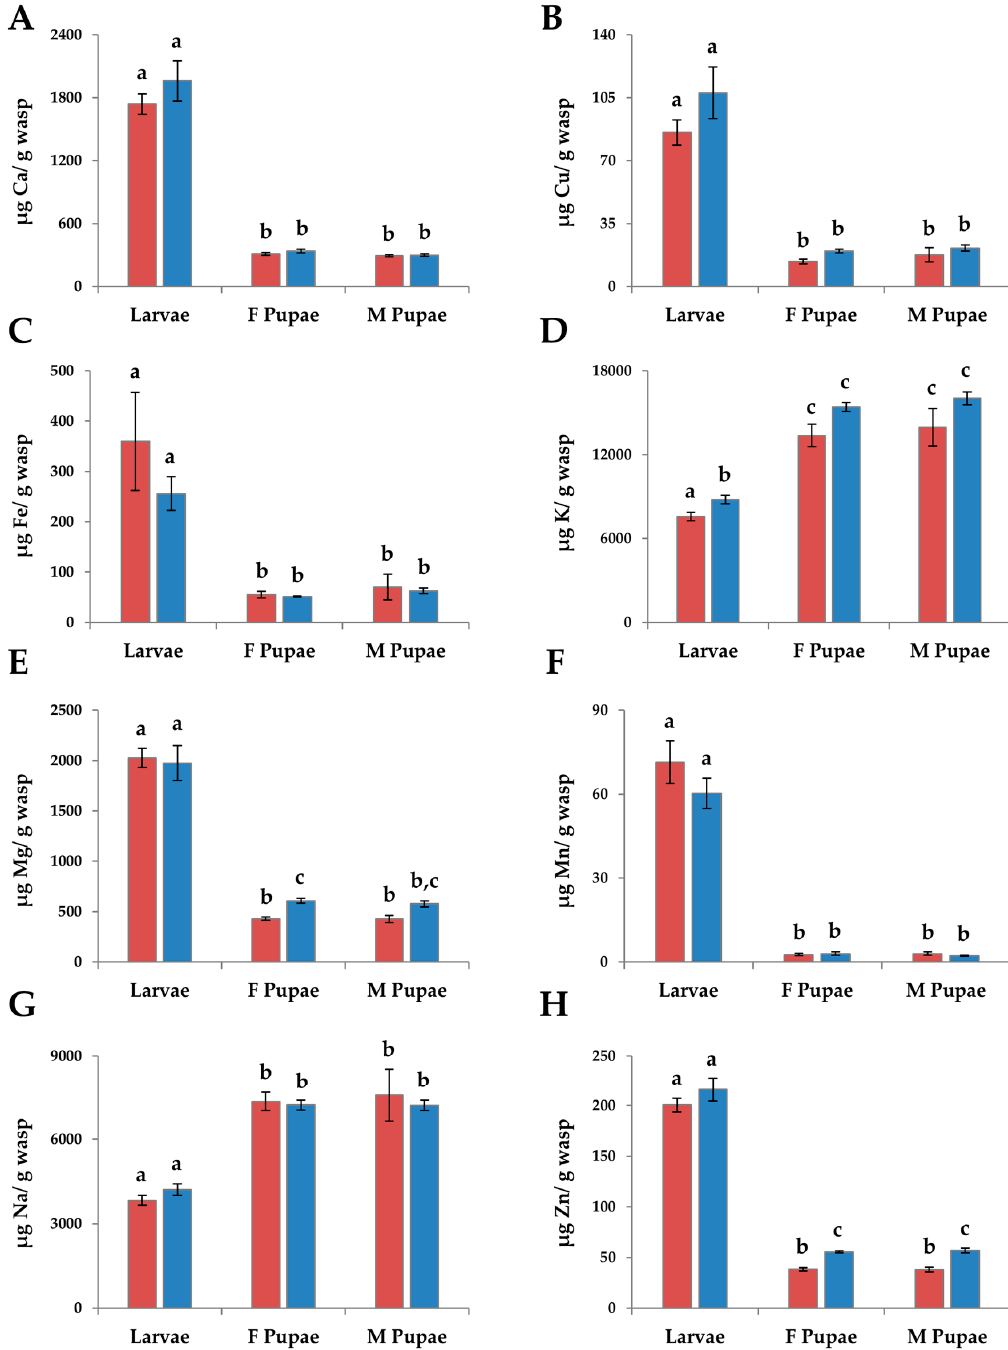
Figure 2. The mean levels of ( A ) Ca; ( B ) Cu; ( C ) Fe; ( D ) K; ( E ) Mg; ( F ) Mn; ( G ) Na; and ( H ) Zn per unit dry mass in fifth instar larvae (N G1 = 10, N G2 = 10), and male (N G1 = 4, N G2 = 6) and female (N G1 = 5, N G2 = 10) pupae of Trypoxylon lactitarse from the G1 and G2 generations. Error bars indicate standard error. For each graph, different letters (a–c) indicate significant differences between groups (MANOVA followed by THSD).